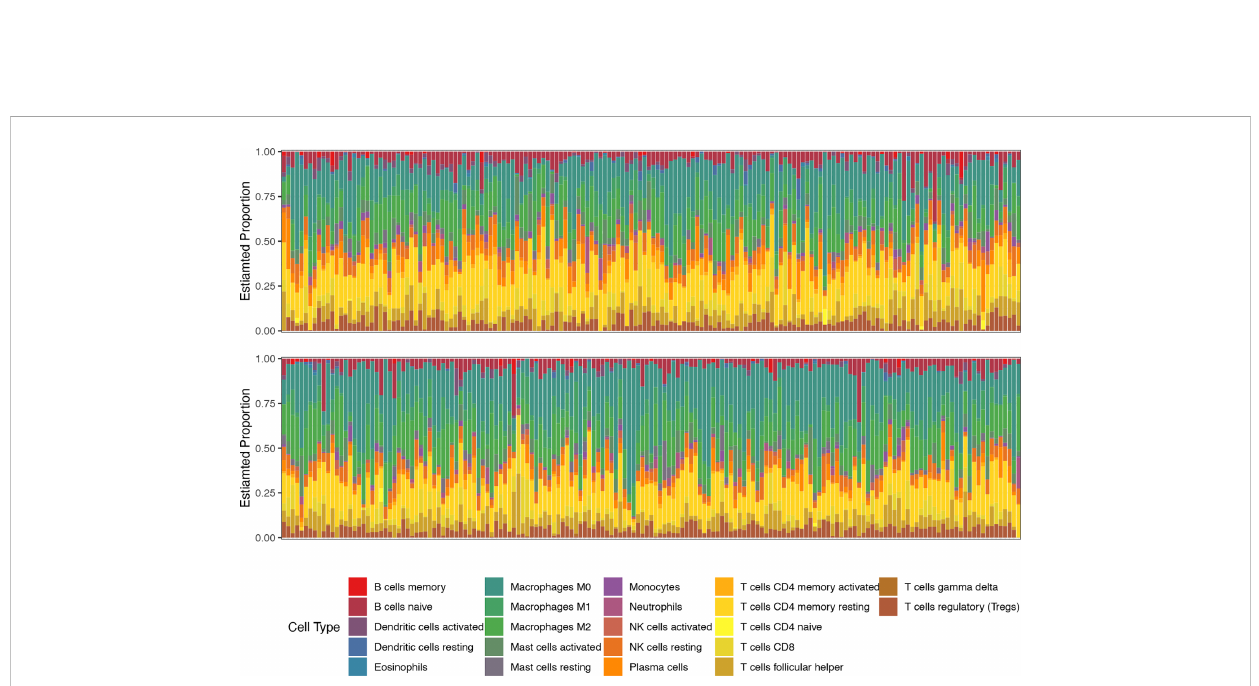
FIGURE 4 The proportions of 22 types of immune cells in each sample of low-risk (top line) and high-risk (bottom line) groups revealed by